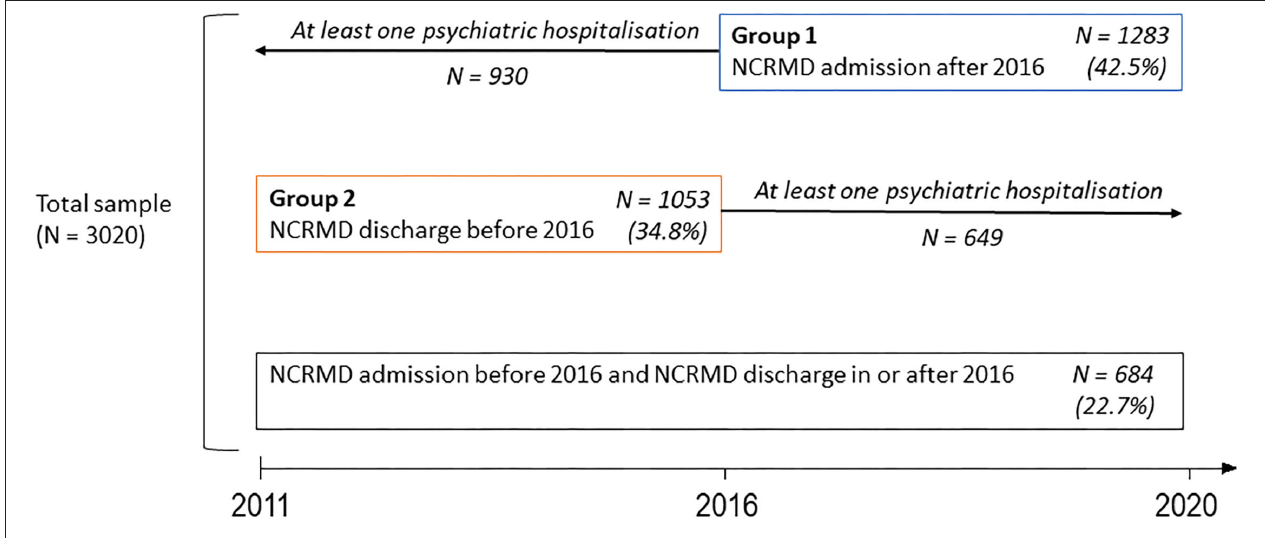
FIGURE 2 | Characterization of the sample of people found not criminally responsible on account of mental disorder in France (2011–2020).